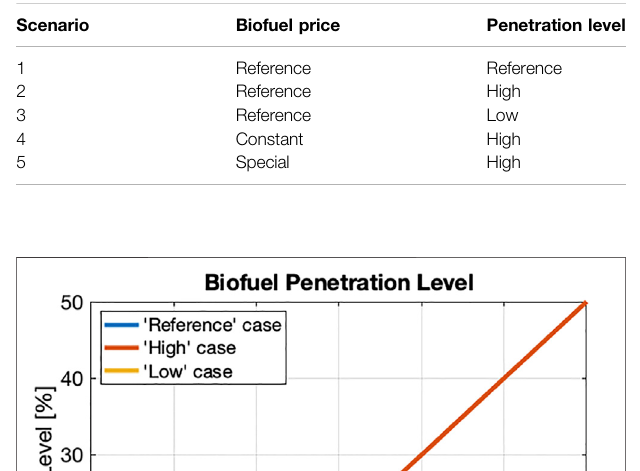
FIGURE 2 | SAF carbon emission intensities for different biofuel penetration levels considered in this